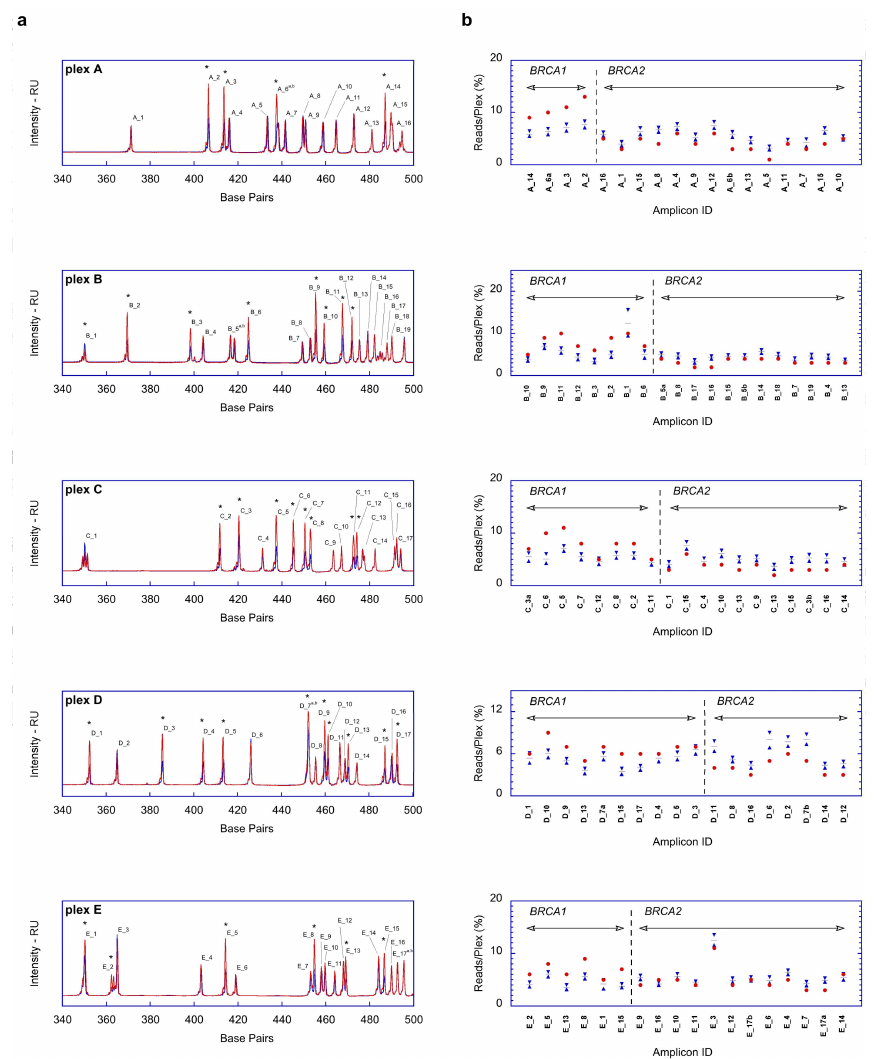
Figure 1. Quality control analyses performed with in house script on fragment analysis (FA) and Next-Generation Sequencing (NGS) dataset. ( a ) Superimposition of normalized electropherograms obtained from the five plexes of the Sample 5, (whole deletion of BRCA2 , red line) and True Negative sample, True Negative CNV (TN-CNV) (blue line). The plot shows the distribution of the amplicon resolved in each plex, during Fragment Analysis assay, as a function of base pair length by capillary electrophoresis just before NGS data. For each peak the corresponding ID, according to Table A1, is reported. All of the amplicons with altered profile are flagged by an asterisk ( b ) BRCA1 and BRCA2 Read Coverage (RC) frequency values in all plexes of Sample 5, showing the relative amount of polymerase chain reaction (PCR) products belonging to BRCA1 amplicon and BRCA2 (red circles). The RC average and confidence intervals (CI99%) calculated using the run statistics (plotted as blue dashes and blue triangles,